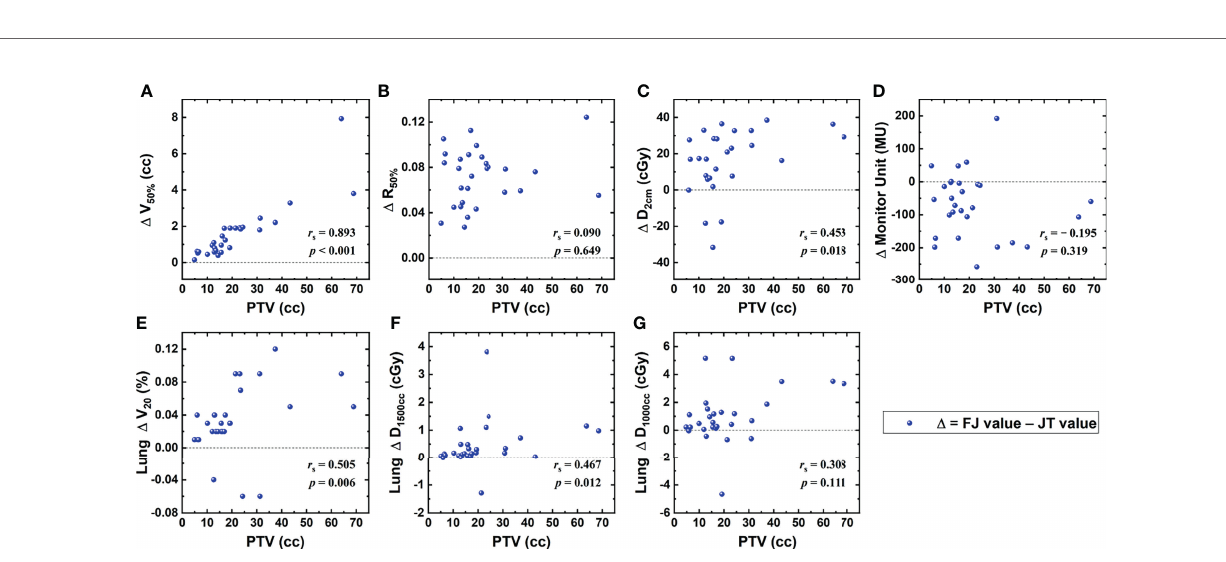
FIGURE 2 | Correlations between the planning target volume (PTV) and the differences in dosimetric parameters between fi xed-jaw (FJ) and jaw tracking (JT) plans, including V 50% of the PTV (A) , R 50% (B) , D 2cm (C) , monitor unit (MU) (D) , and V 20Gy (E) , D 1,500cc (F) , and D 1,000cc (G) of the lung.